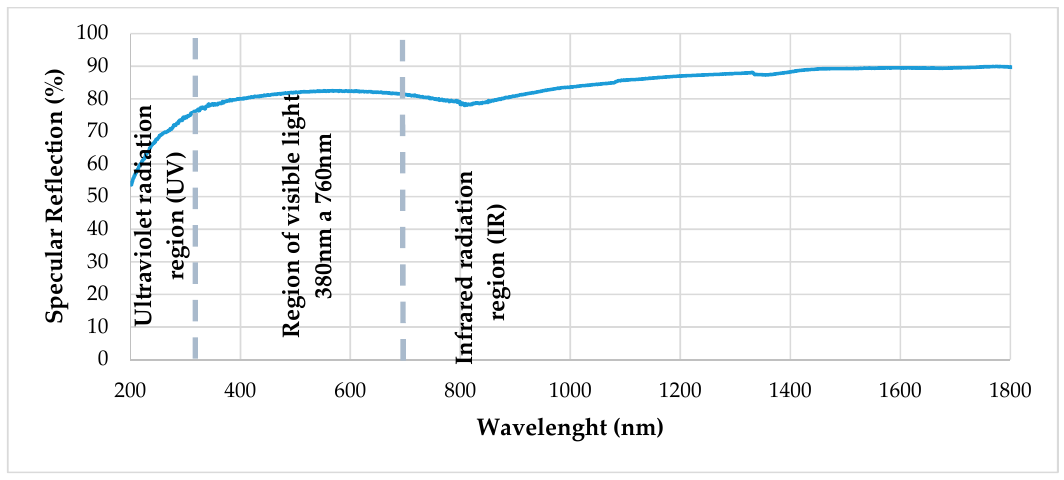
Figure 3. Reflection tests (ABS).